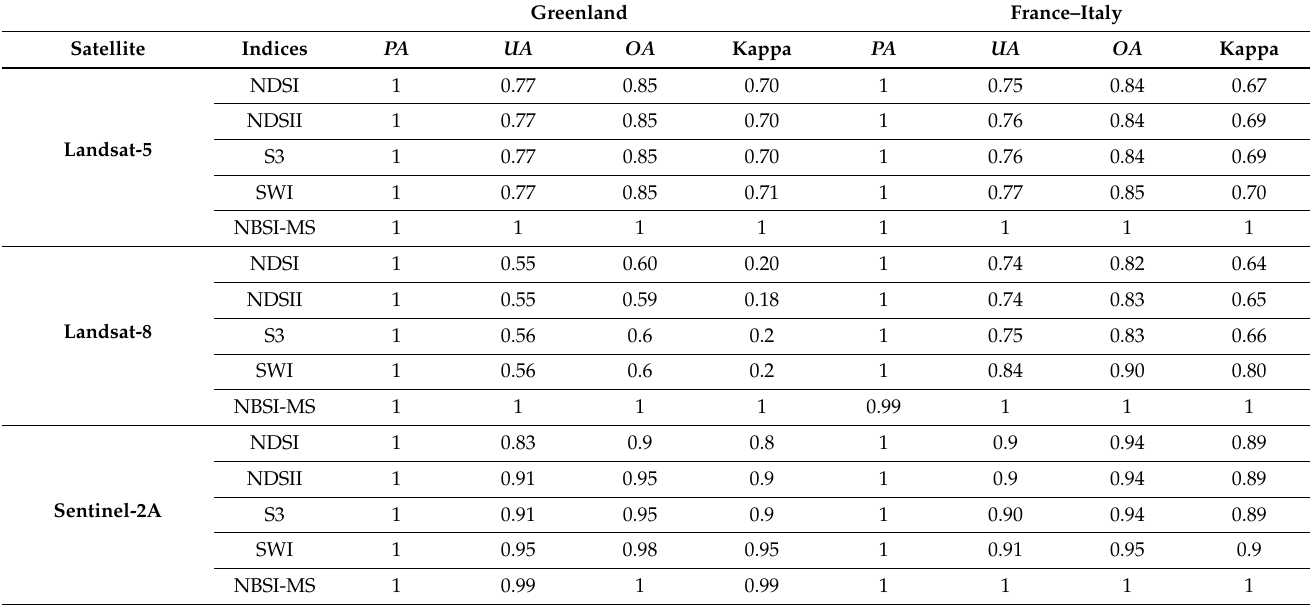
Table 9. Precision assessment based on Ground Reference Test Pixel validation for different Snow-Cover Indices.